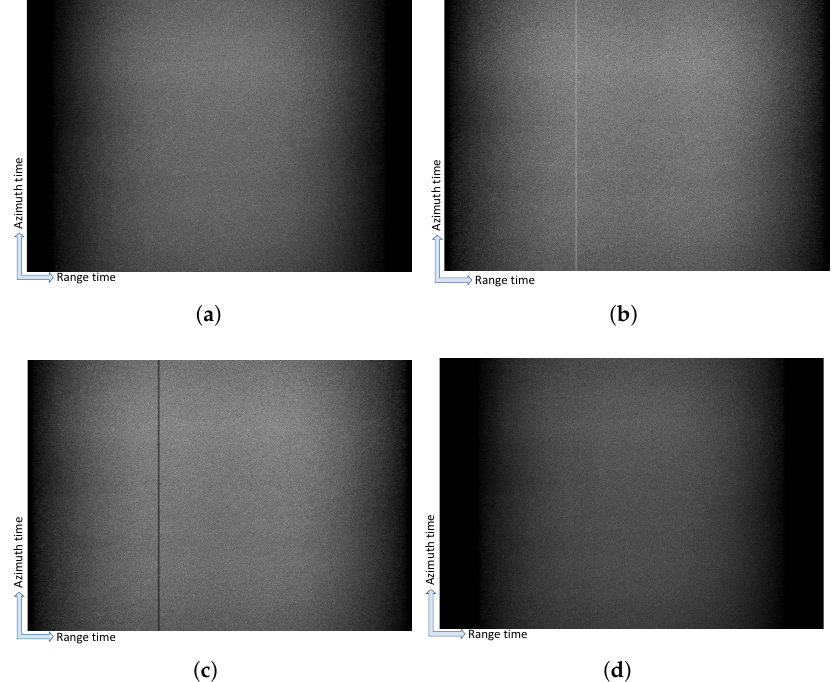
Figure 14. ( a ) The received signal. ( b ) After pulse compression for synchronization signal. ( c ) Af- ter the removal of the mainlobe of compressed synchronization signal. ( d ) After inverse pulse compression processing.